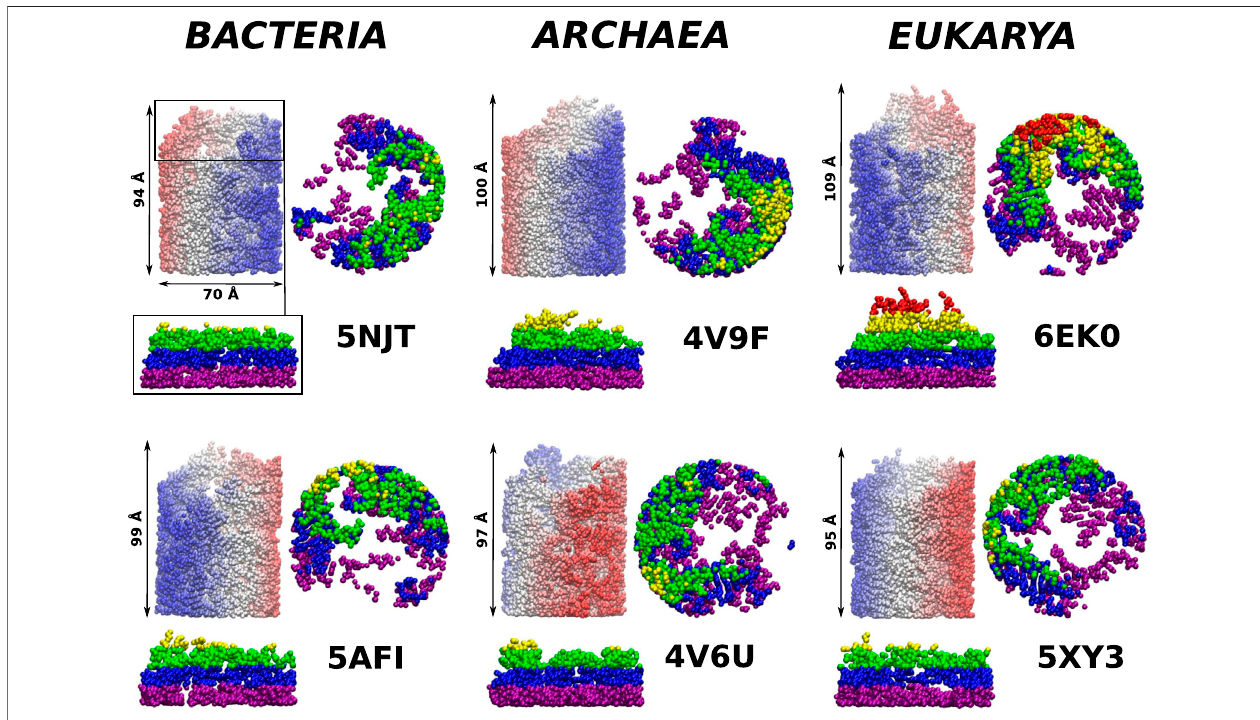
FIGURE 4 | The ribosomal exit tunnels (the red shape) detected by the SPACEBALL algorithm (Chwastyk et al., 2014; Chwastyk et al., 2016a; Chwastyk et al., 2016b) within the ribosomal structures from different domains of life. The arrows point to the constriction sites (CS1 and CS2). The green shadow represents the all atoms that are present in the cut-out part of the ribosomes. The PTC is always at the bottom of each